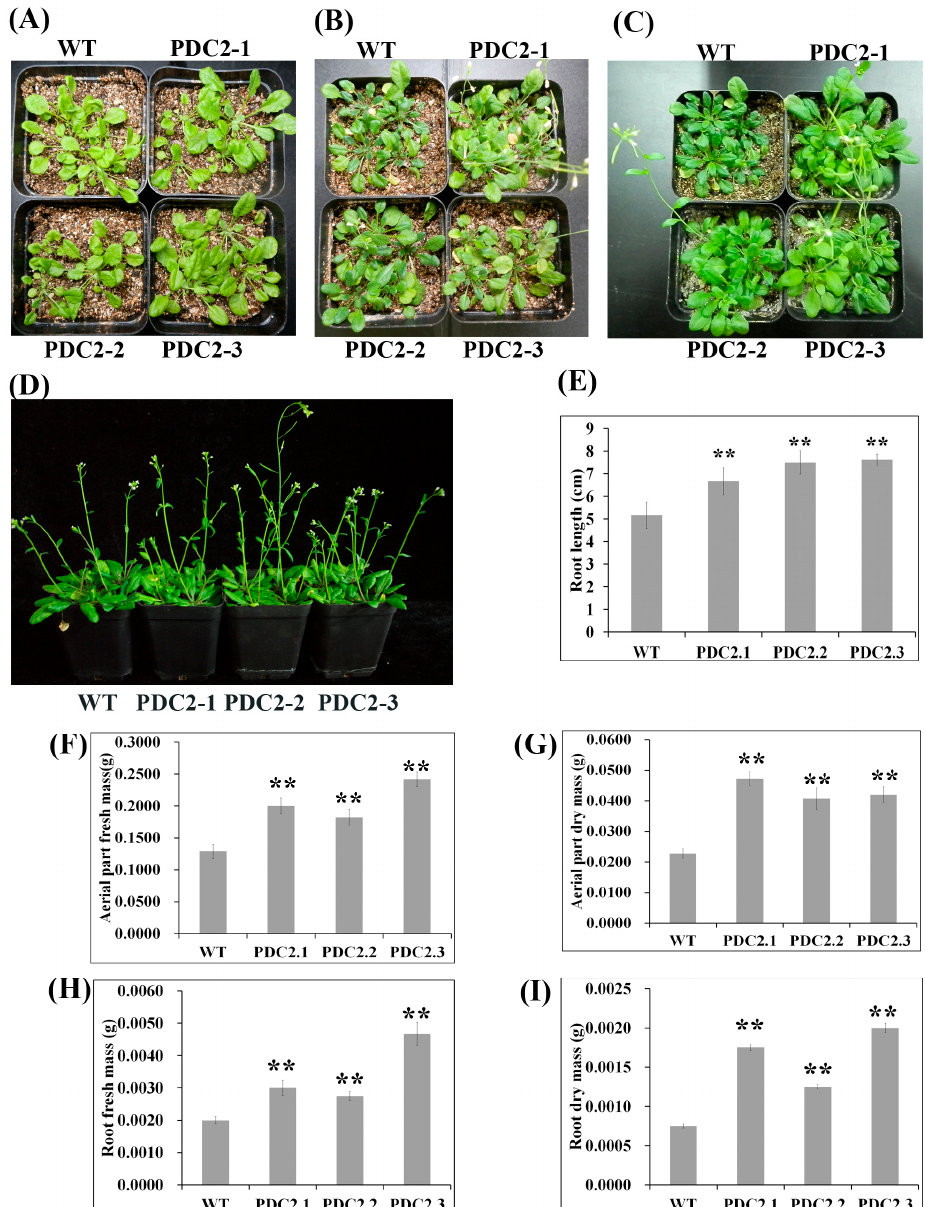
Figure 3. Five-week-old plants of transgenic Arabidopsis PDC2-1, PDC2-2, PDC2-3, and wild-type (WT) were used to detect waterlogging tolerance. ( A ) Before waterlogging assay; ( B ) waterlogging for two weeks; ( C ) growth recovery for one week after waterlogging stress; ( D ) plant growth under normal condition for 56 d (CK); ( E ) root length of C; ( F ) aerial part fresh mass of C; ( G ) aerial part dry mass of C; ( H ) root fresh mass of C; and ( I ) root dry mass of C. For E, F, G, H, and I, each column is the average of three replicates and each replicate has 36 plants. Bars indicate SD. Double asterisks indicate significant differences compared with WT line values ( ** p < 0.01).